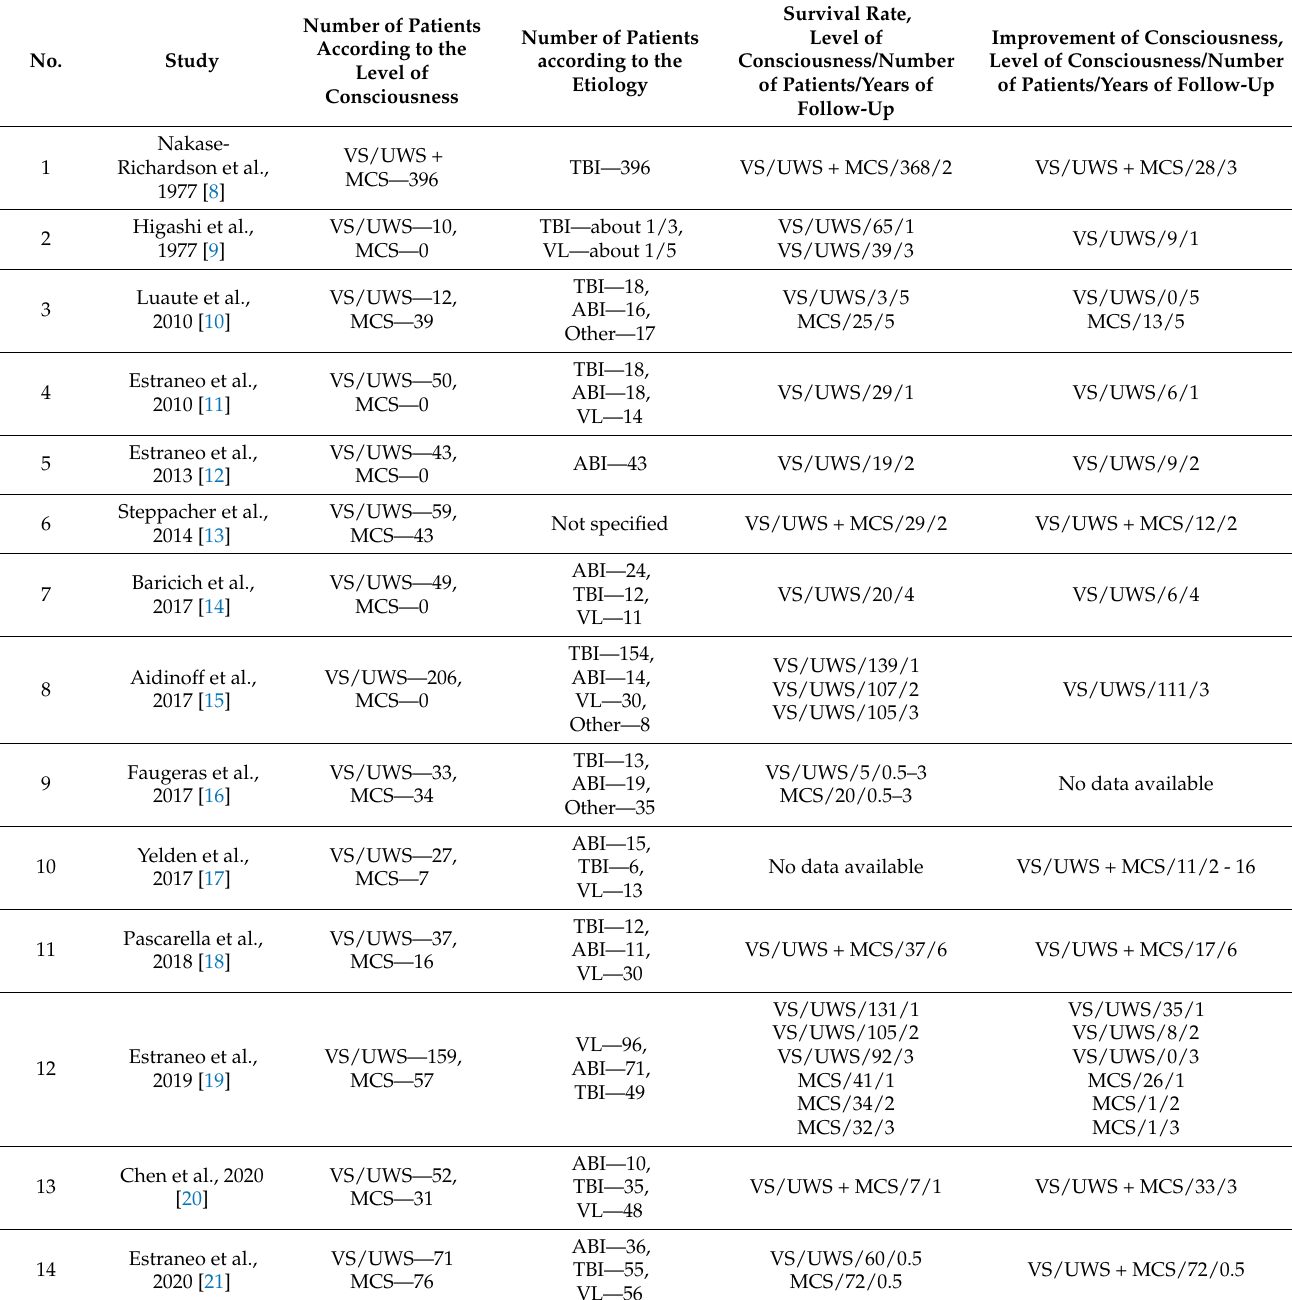
Table 1. Published data on survival and consciousness improvement in DOC